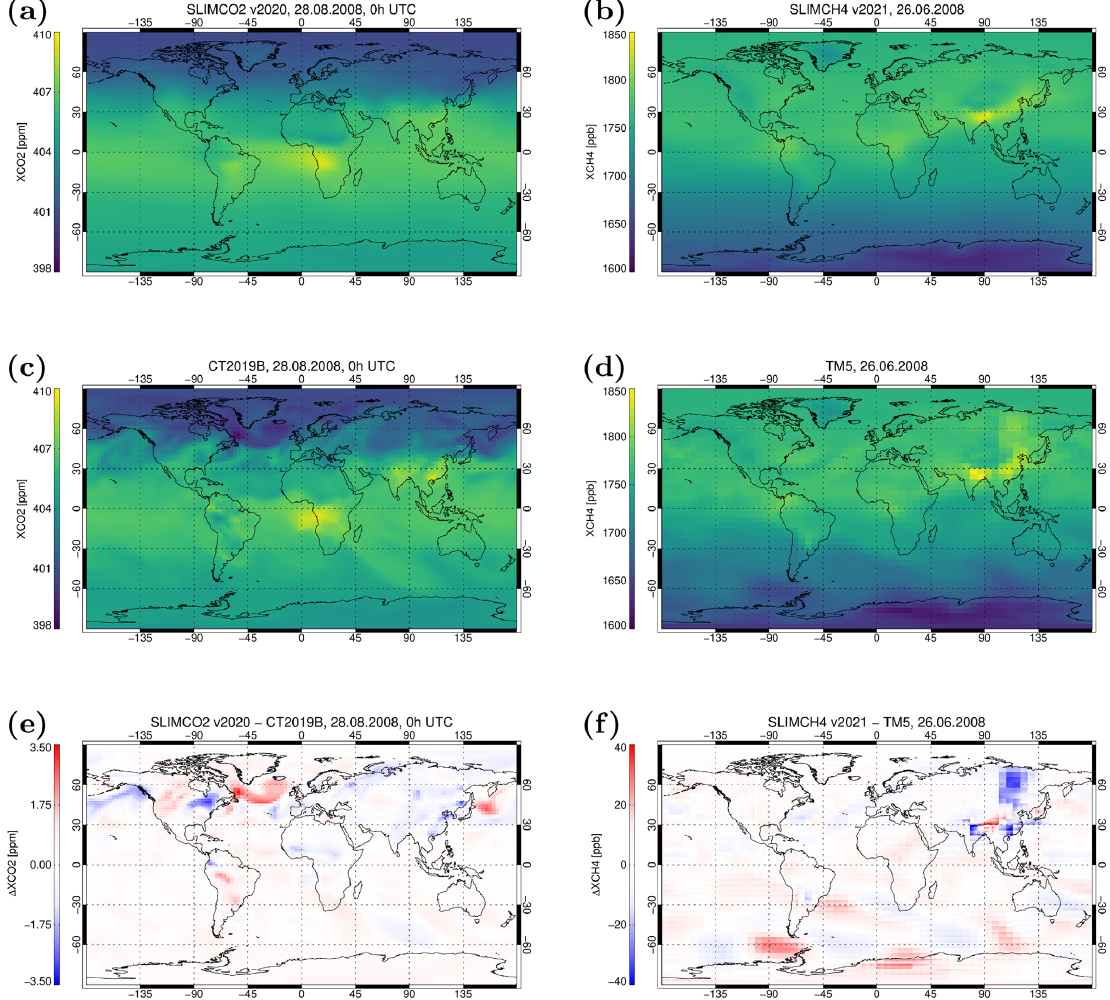
Figure A2. Example maps of SLIMCO2 (a) and SLIMCH4 (b) data. Panels (c) and (d) show corresponding data from the underlying models (CT2019B, TM5). The differences between the SLIM results and these model data are shown in panels (e) and (f) .